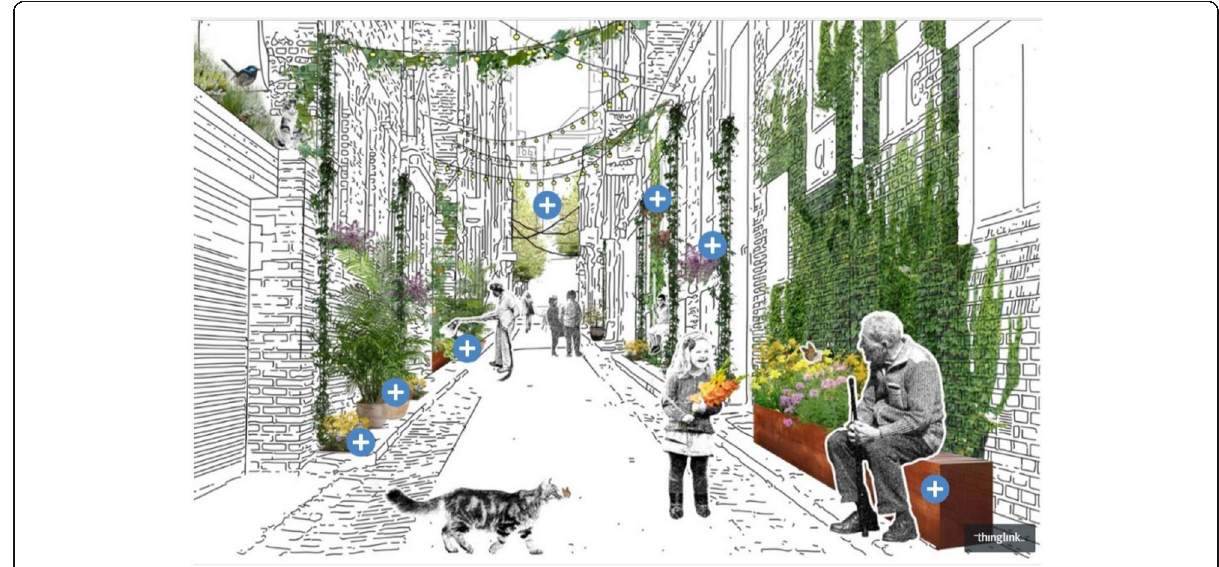
Fig. 4 Meyers Place in Melbourne. Source: